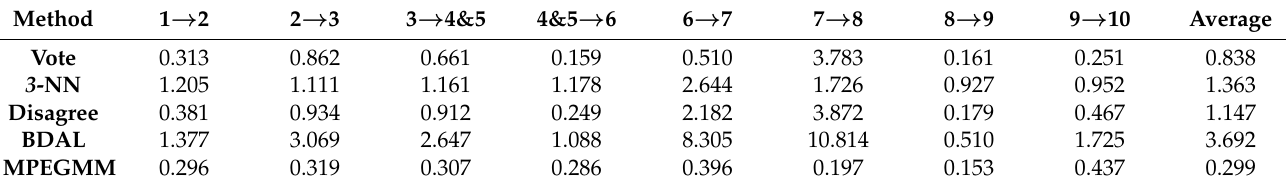
Figure 9. Estimated number of noisy labels with w (dataset B). ( a ) Noisy number of batch 2; ( b ) noisy number of batch 3. Table 6. Average time of identifying one instance